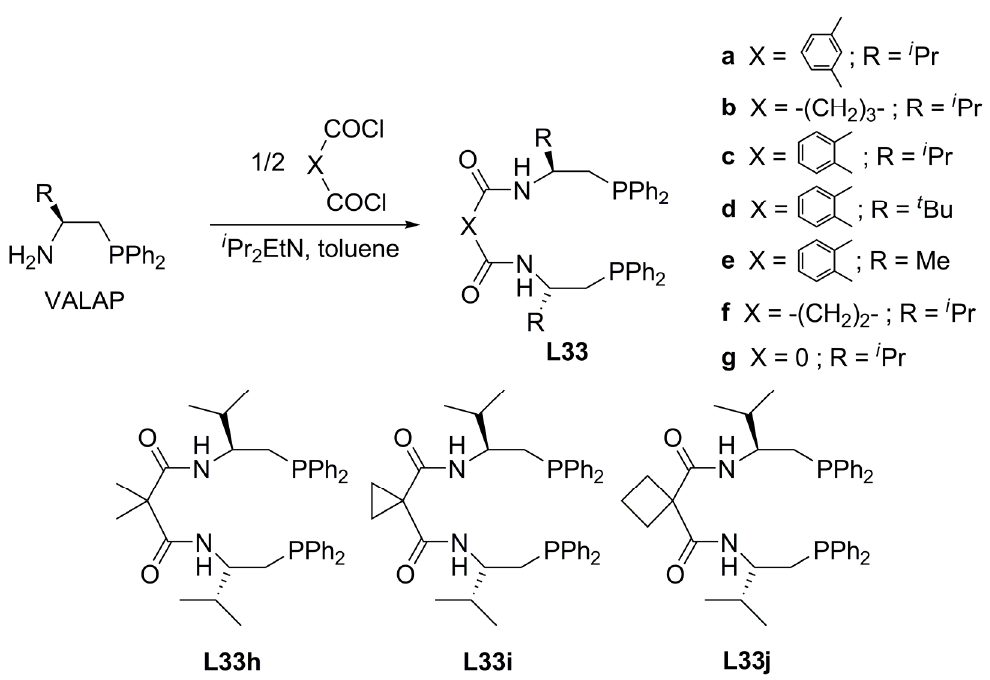
Figure 14. L - Valine-based hybrid